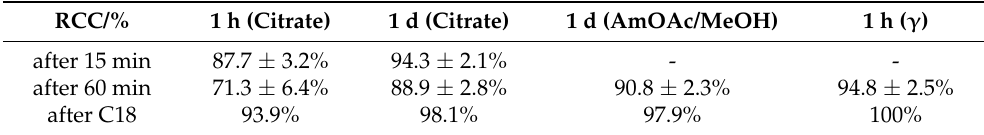
Table 1. Comparison of the determined radiochemical conversion rates (RCCs) with the different methods at different time points of the reaction (15 and 60 min: n = 3; after C18 cartridge purification: n = 1). The imaging/measurement was carried out 1 hour (1 h) or 1 day (1 d) after the radio TLC had been developed.